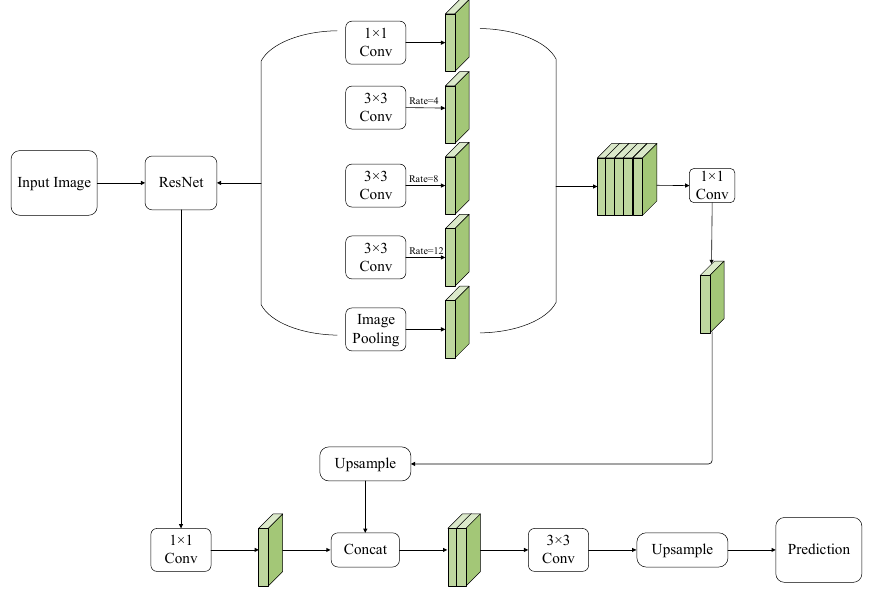
Figure 3. The architecture of DeepLabV3+ for UOD-SS method.